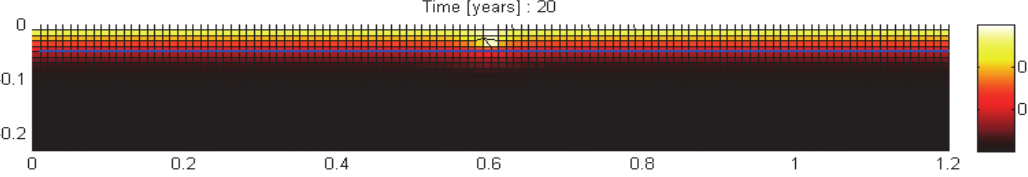
Figure 2: The sample contour plot of concentration of chloride ions in a concrete bridge deck with a crack. Deterministic solution for an exposure period t = 20 years shows the FEA meshed elements and concentration in the form of contours.